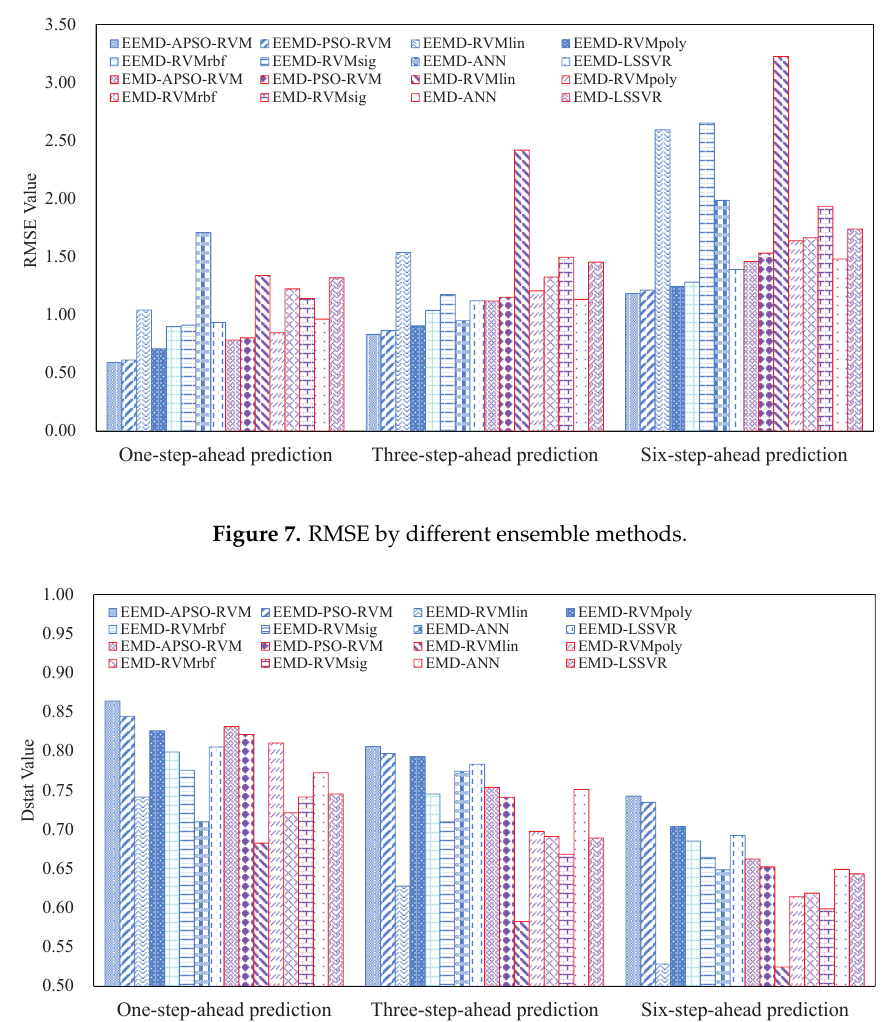
Figure 8. Dstat by different ensemble